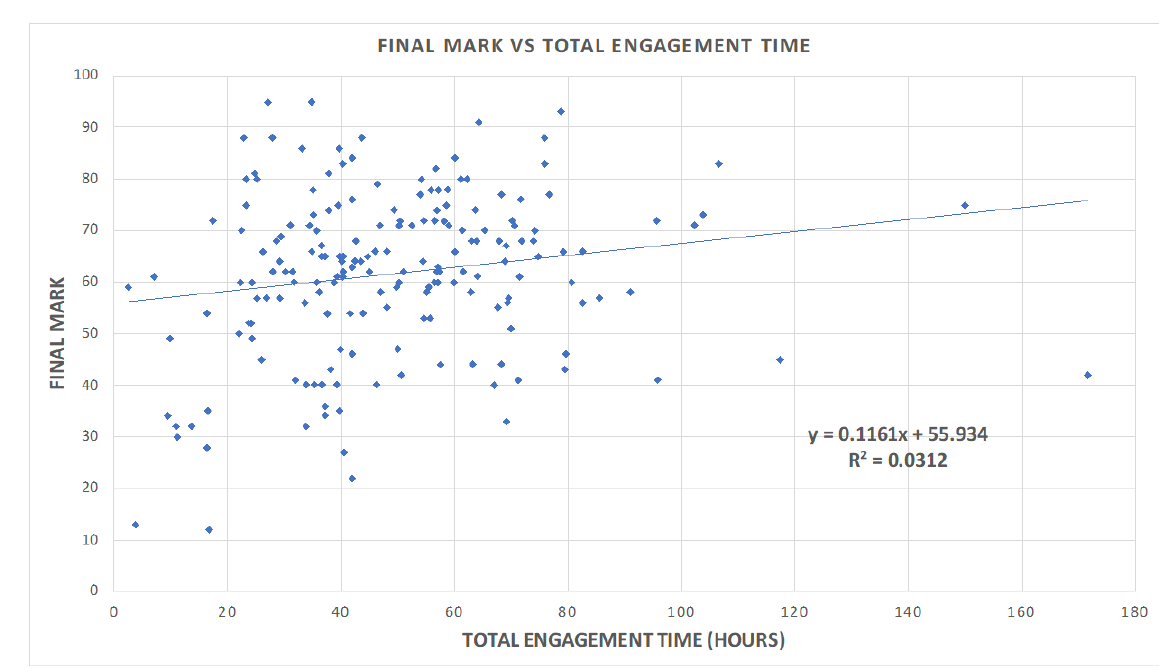
Figure 8 . Final Mark vs Total Engagement Time